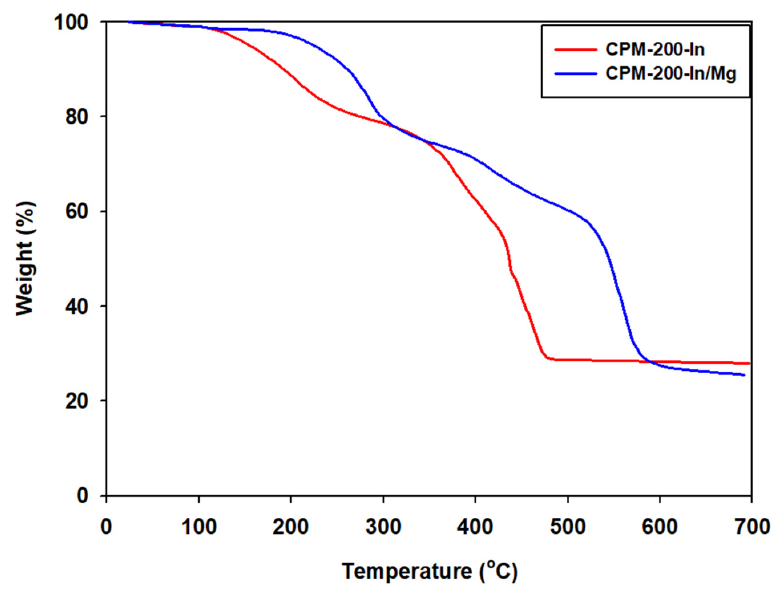
Figure 3. FT-IR spectrum of CPM-200-In and CPM-200-In/Mg. TGA results of CPM-200-In and CPM-200-In/Mg (Figure 4) showed an initial weight loss of solvent inside their pores around 130 °C and 200 °C. Even after the initial weight loss, CPM-200-In/Mg exhibited better thermal stability than CPM-200-In, probably due to the better crystallinity from the synergy effect of two metals during CPM-200-In/M crystallization process [60] and/or to the smaller micropore diameter for CPM-200-In/M compared to CPM-200-In.